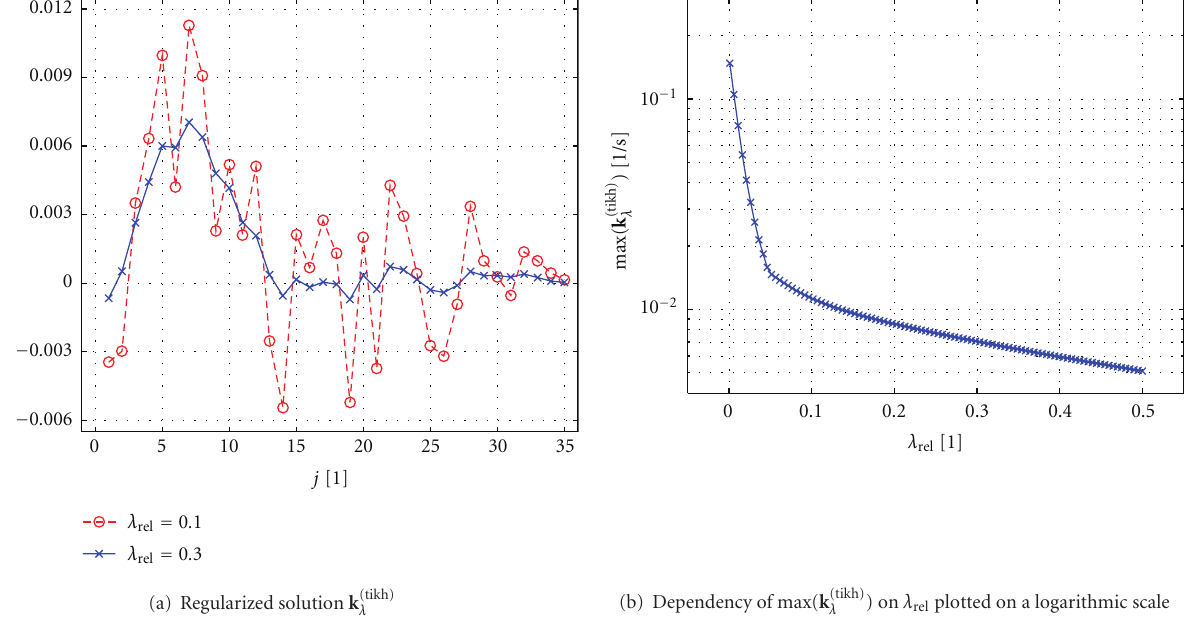
Figure 10: Deconvolution with Tikhonov regularization: (a) Regularized solution k (tikh) λ for two di ff erent regularization parameters λ rel